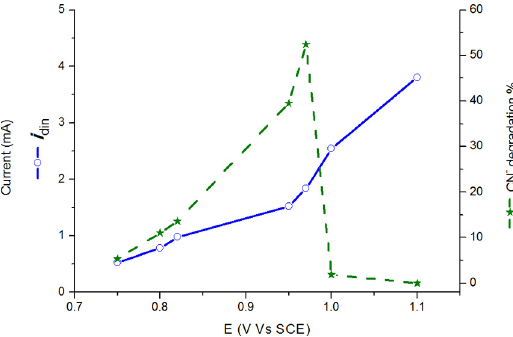
Figure 8. Photoelectrocatalytic oxidation of CN - (100 ppm, pH=11) on TiO TNF film during 120 minutes. 2